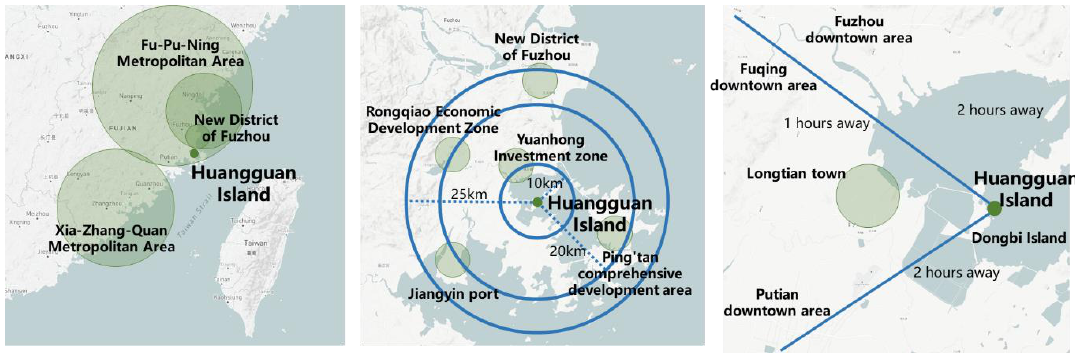
Figure 1. Location of Huangguan Island.